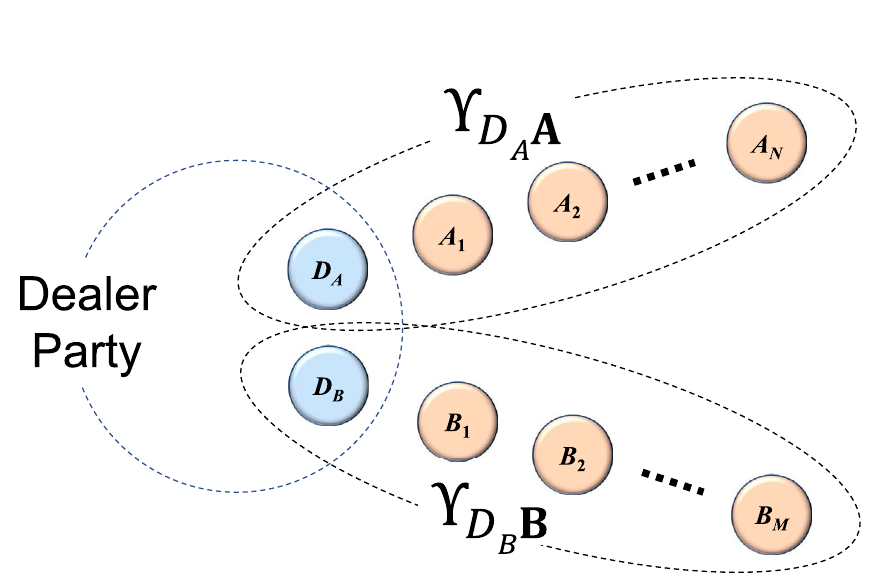
Figure 1. As in Theorem 2, from the ϒ D A , a private state ϒ DA k or a QCR state ϒ D A parties can be obtained by LOCC, where A ′